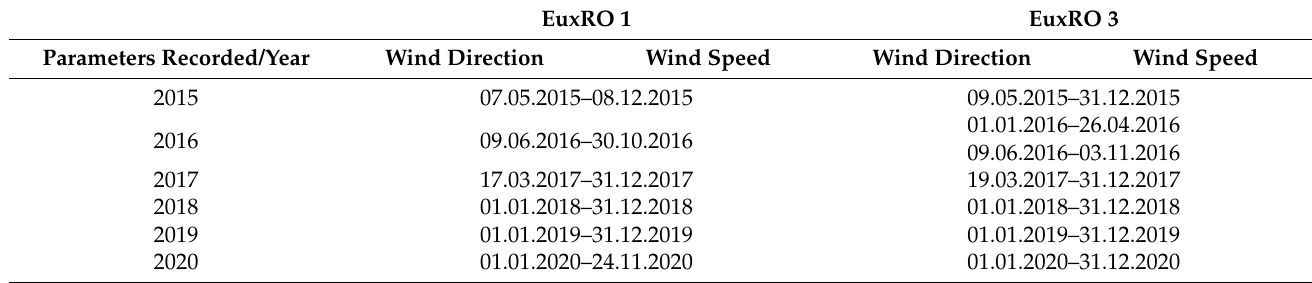
Table 2. Characteristics of the datasets considered for evaluation. EuxRO 1 EuxRO 3 Parameters Recorded/Year Wind Direction